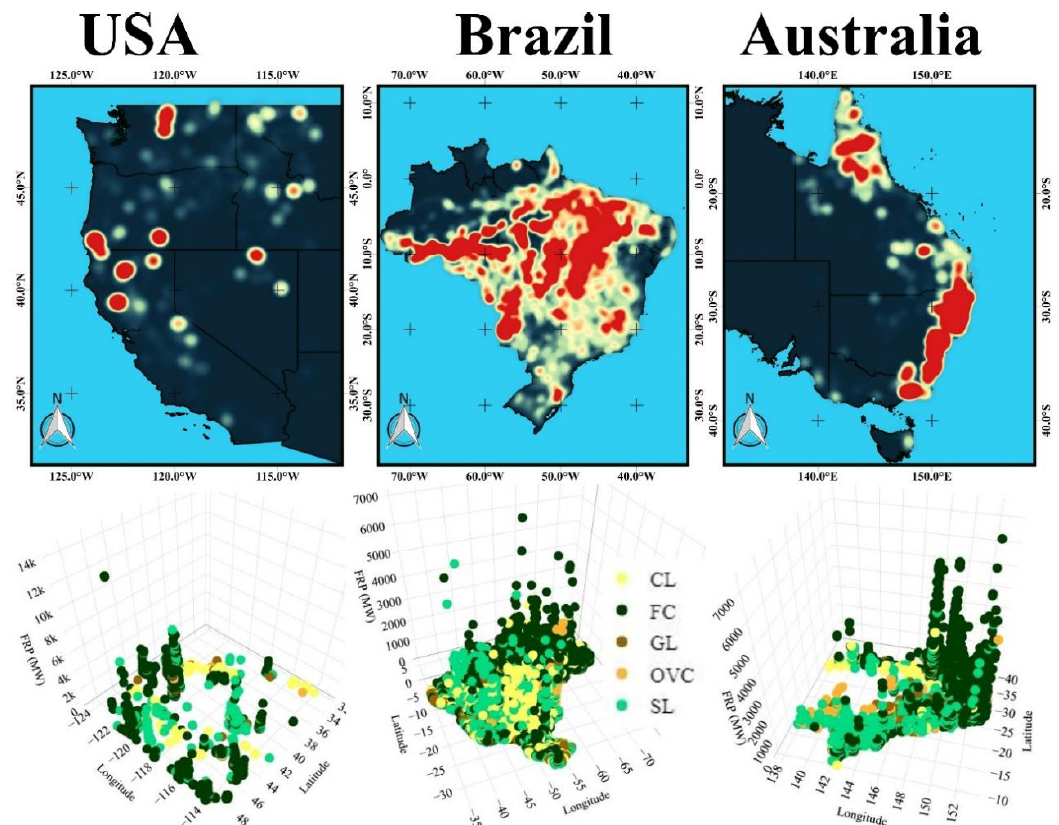
Figure 2. The heat map (top panel) of Active Fires (AF) and corresponding Fire Radiative Power by vegetation cover type (FRP, bottom-panel) for western USA (i.e., August–September 2018), Brazil (i.e., August–September 2019) and eastern Australia fires (i.e., November–December 2019). Red regions in the heat map (top-panel) represent higher proximity and number of fires (i.e., more AF points) than yellow areas, which show more dispersed fires. CL, FC, GL, OVC and SL denote cultivated land, forest cover, grassland, other vegetation covers and shrubland, respectively. Table 1. Local Moran’s I significant fire clusters and outliers at the three study sites: western USA, Brazil and eastern Australia. HH (LL) indicate statistically significant clusters with similar high (low) fire intensity (FRP, MW) values, while HL (LH) are spatial outliers with a high (low) fire intensity values surrounded by low (high) values.